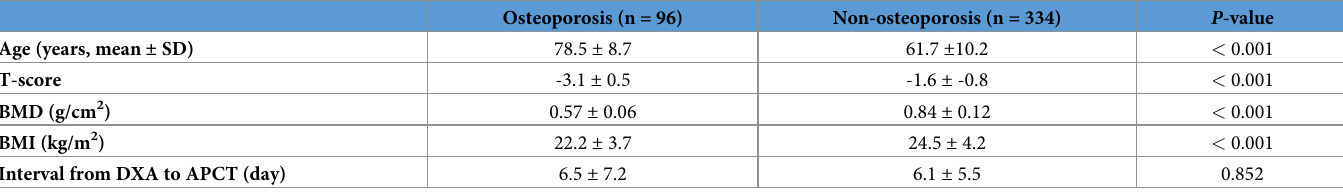
Table 1. Comparison of demographic characteristics between the osteoporosis and non-osteoporosis